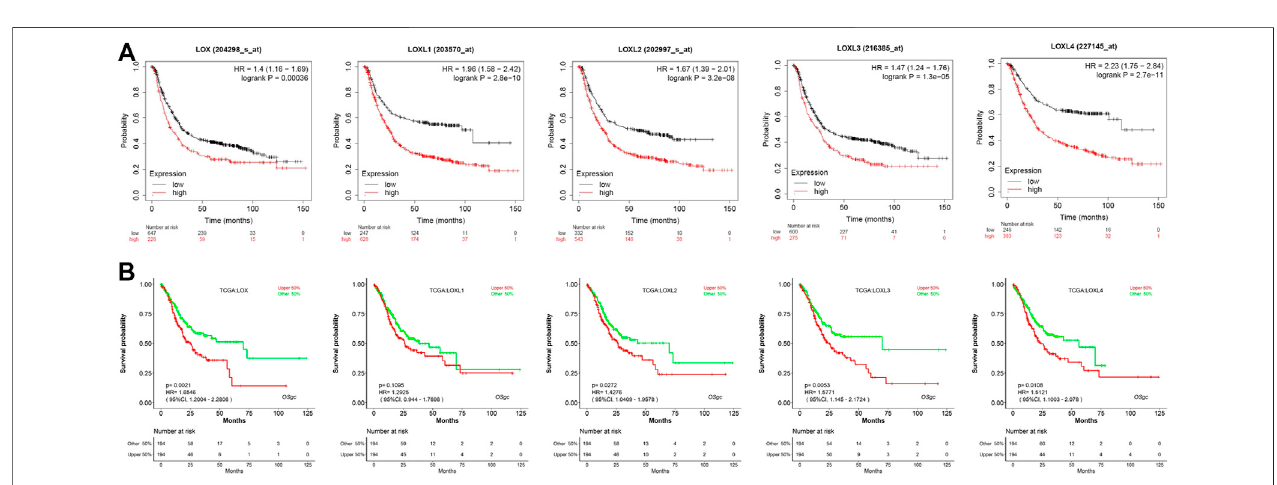
FIGURE 4 | Prognostic feature of mRNA expression of distinct LOX family members in GC patients. (A) OS of Kaplan – Meier plotter revealed that all of LOX family members were signi fi cantly associated with the OS ( p < 0.05); (B) OS of LOGpc indicated that LOX, LOXL2-4 mRNA expression were associated with OS ( p < 0.05).